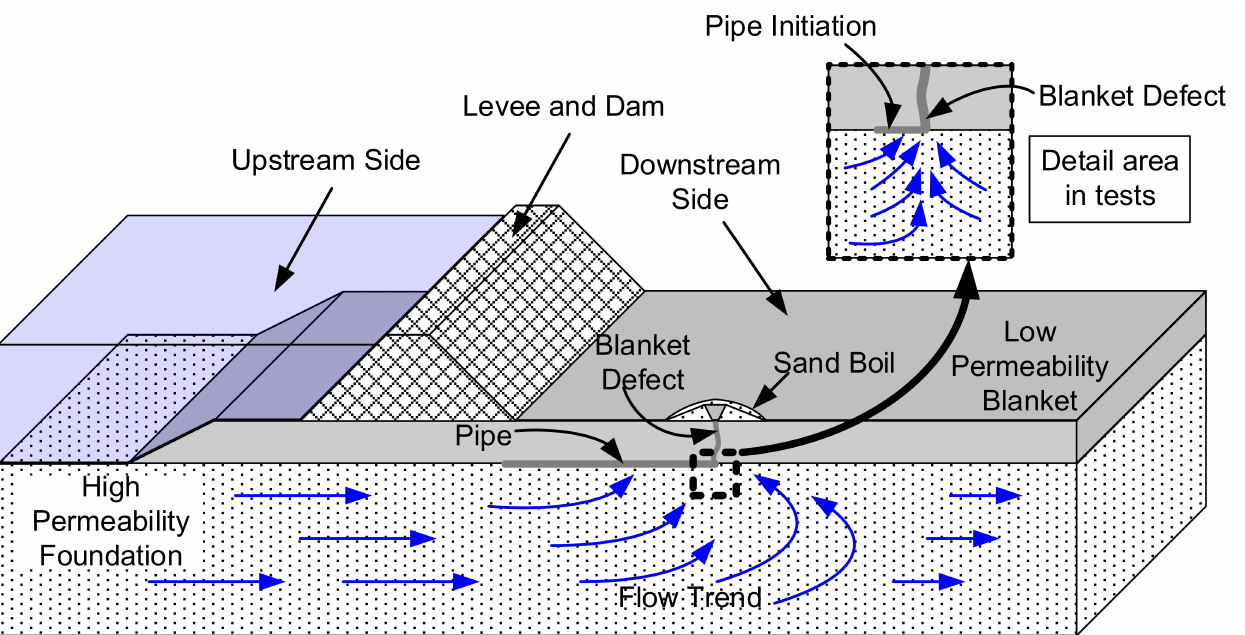
Figure 1. Schematic illustration of BEP and the mechanisms of BEP development (Adapted from Peng et al.